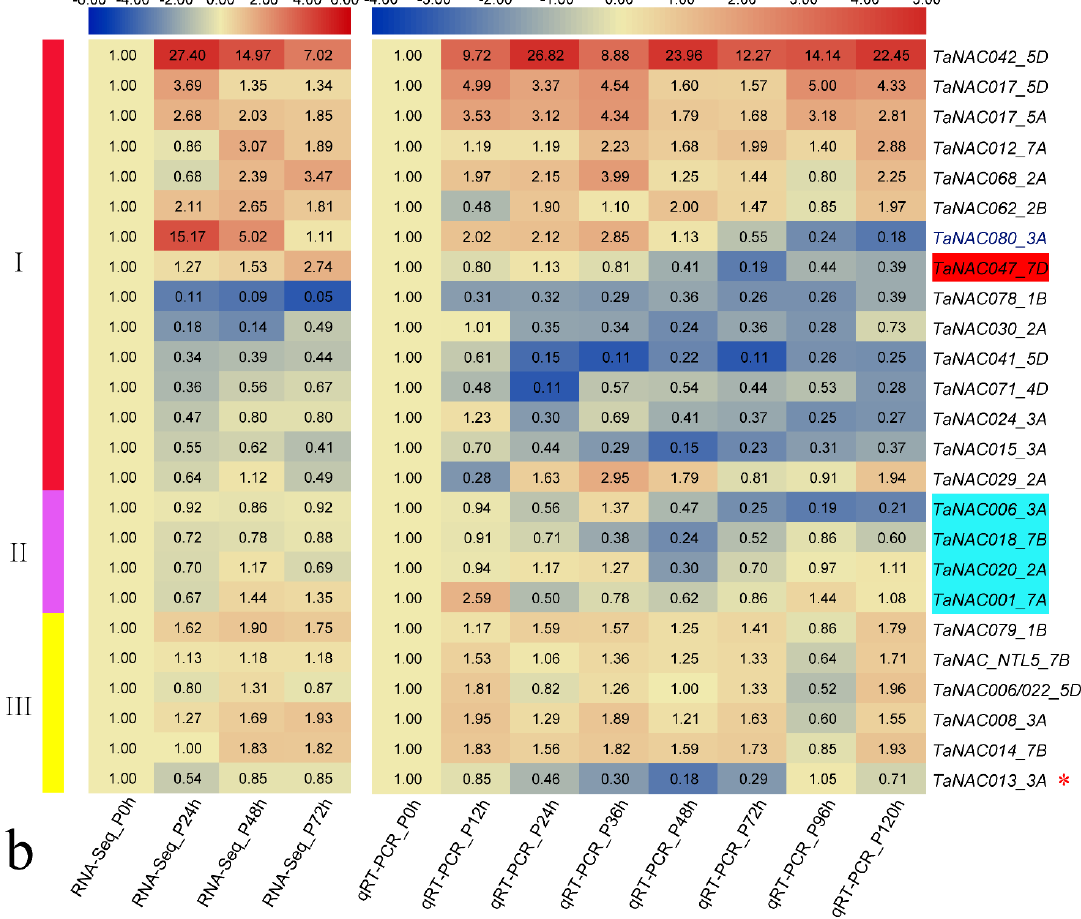
Figure 2b—were non-DE in RNA-seq but DE in qRT-PCR, or the opposite. They all showed inconsistent expression patterns. However, upon combining the two sets of RNA-seq and qRT-PCR comparison results between Pst stress and Bgt stress, respectively, there was no change in DE classification attribute under fungal stress for any gene. In addition, only TaNAC013_3A.1, marked with a red star, showed a changed classification attribute from non-DE in RNA-seq to DE in qRT-PCR, with inconsistency of specific expression patterns under fungal